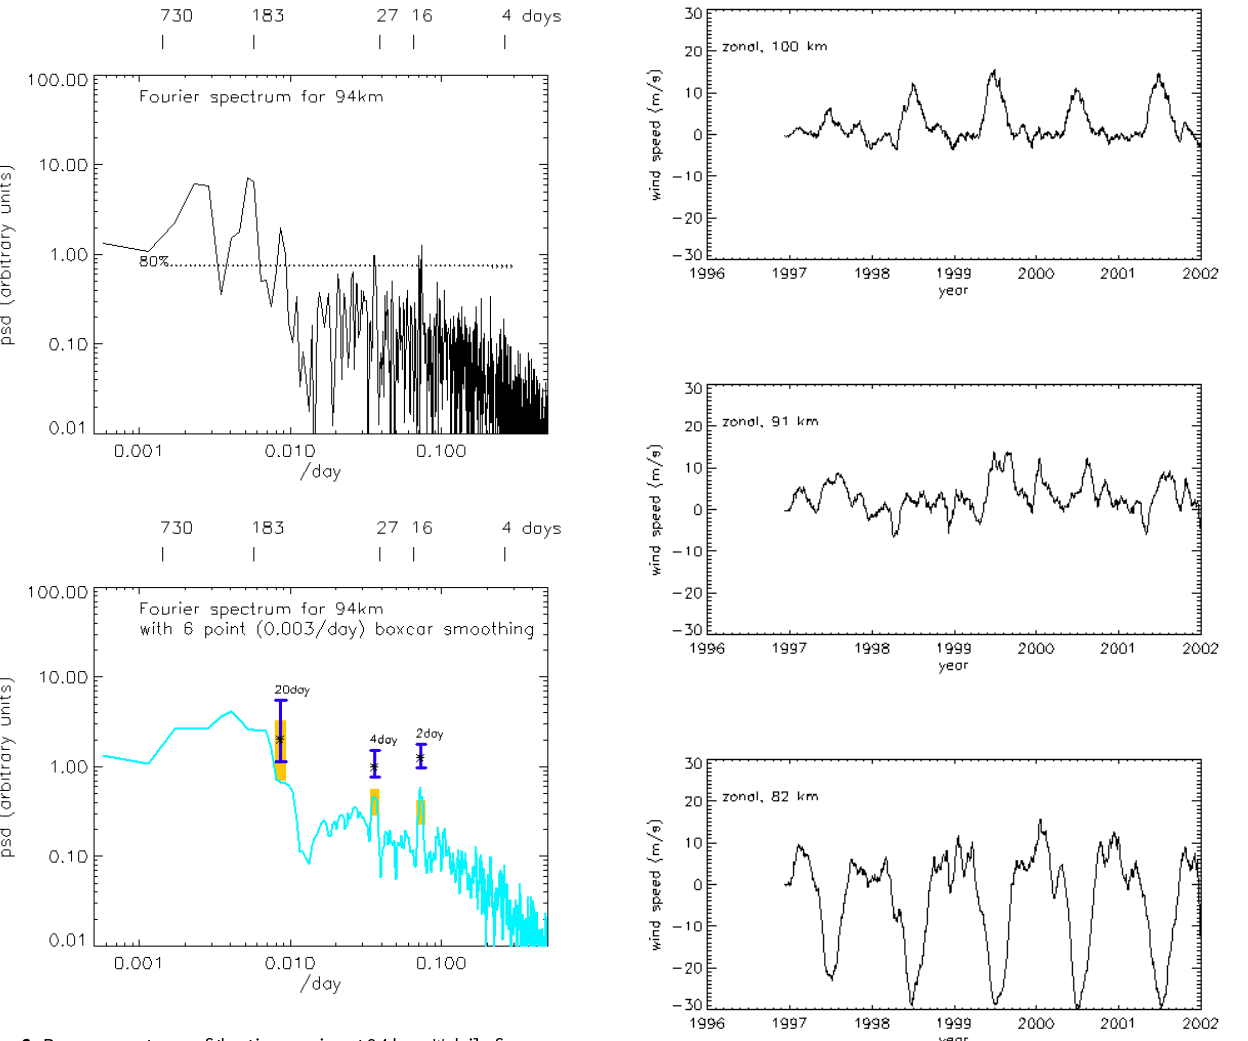
Fig. 6. Power spectrum of the time series at 94km. While frequency is given in day − 1 , the selected corresponding periods in days are in- dicated in the upper part of each panel. Upper panel: full resolution spectrum, the horizontal dotted line indicating the power spectral density corresponding to the Lomb 80% confidence level. Lower panel: Smoothed spectrum with χ 2 accuracy limits for the ∼ 122- day, ∼ 16-day and ∼ 27-day periods (see text for details).